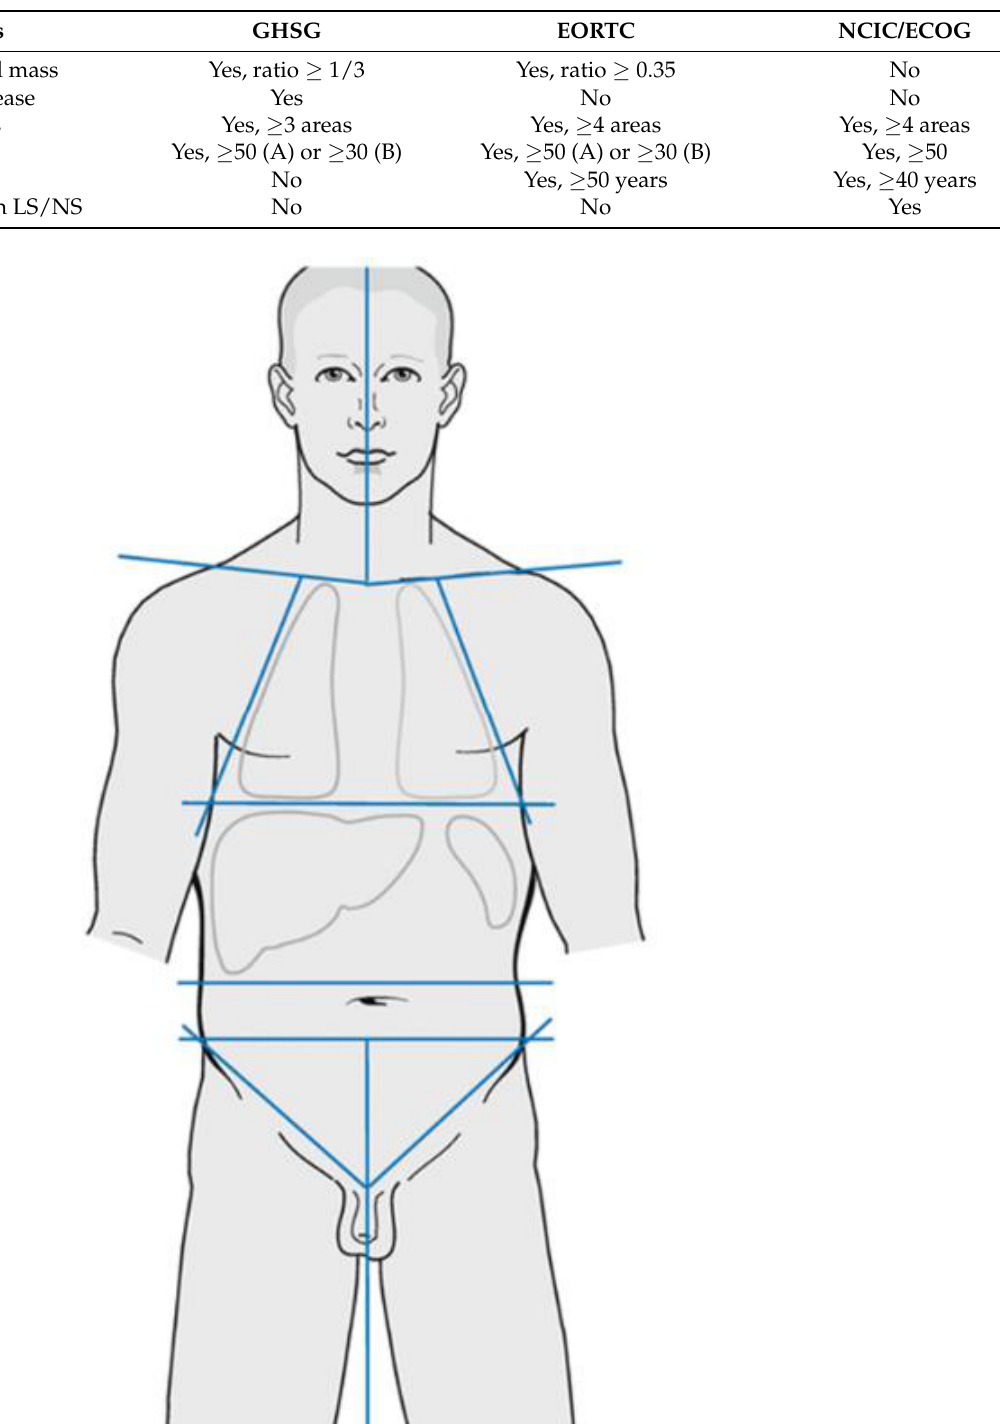
Table 1. Risk factor definitions in Hodgkin Lymphoma. Patients classed as “unfavourable” if one or more risk factor is present. ESR, erythrocyte sedimentation rate; A, without B-symptoms; B, with B-symptoms; LP, lymphocyte predominant; NS, nodular sclerosis.